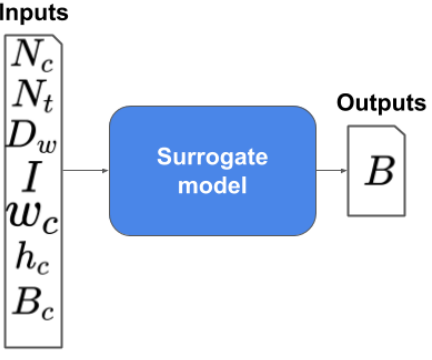
Figure 8. Magnetic circuit